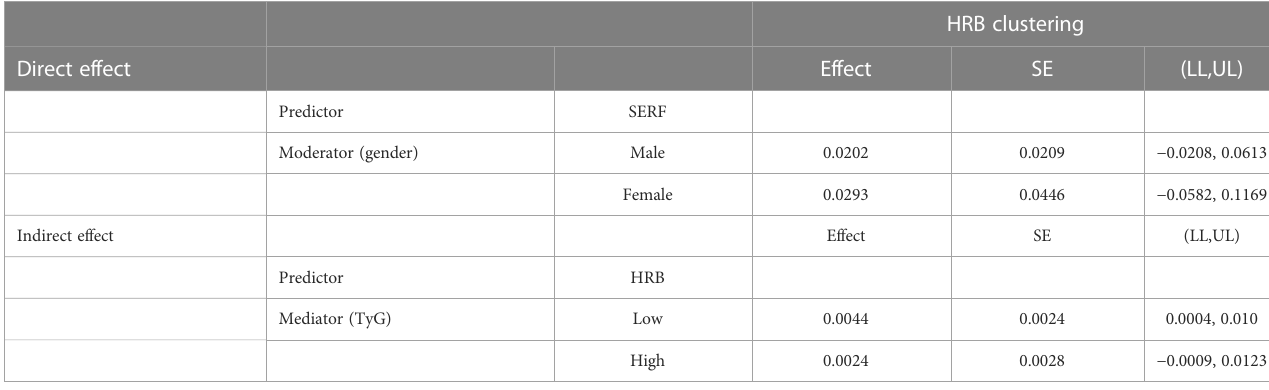
TABLE 9 Bootstrapped conditional direct and indirect effects.